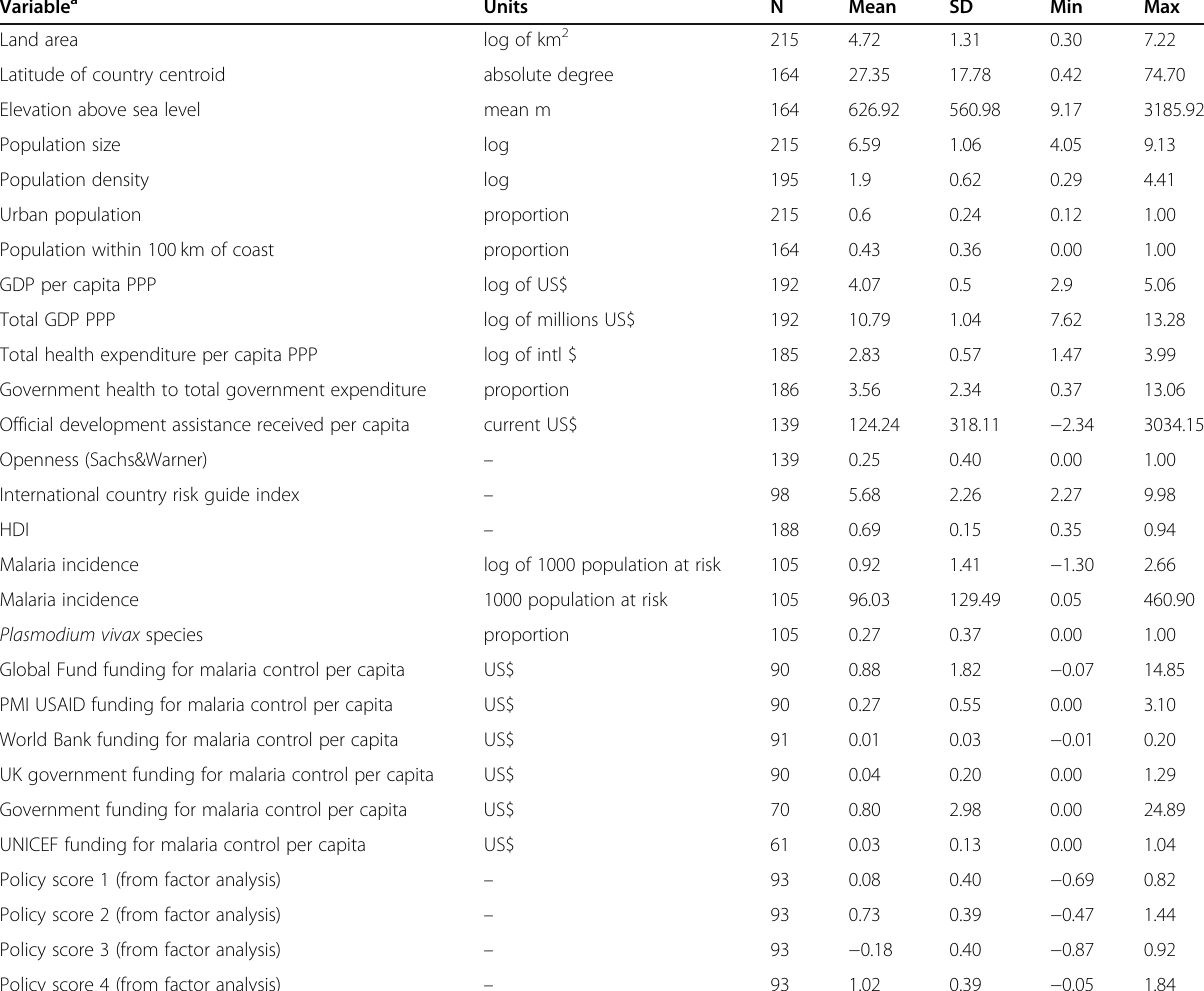
Table 1 Summary statistics of continuous